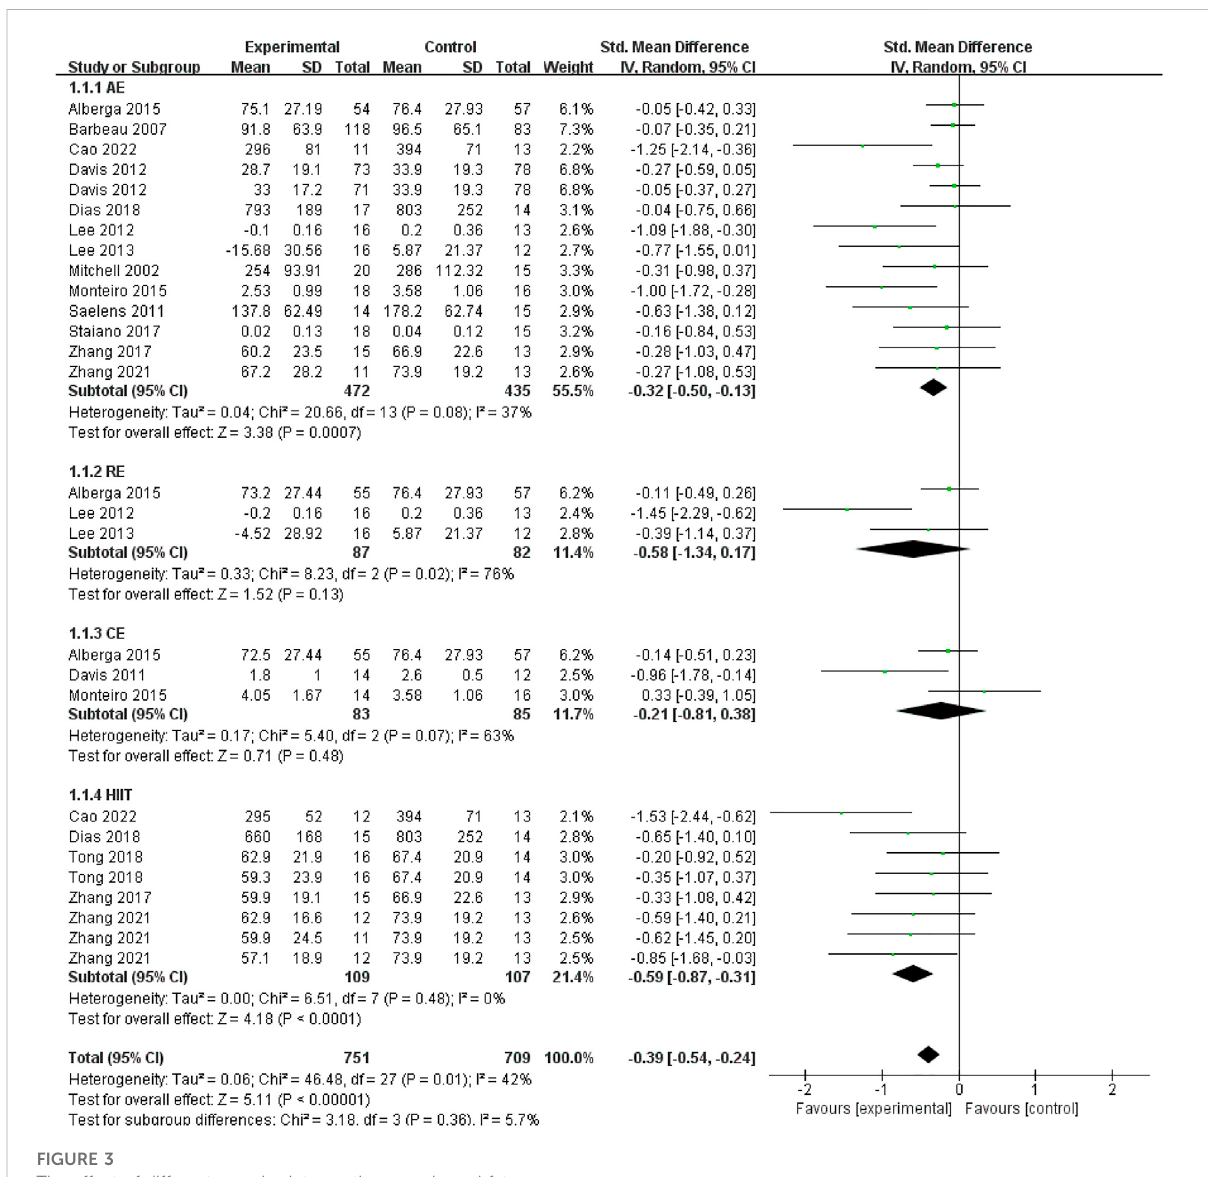
FIGURE 3 The effect of different exercise interventions on visceral